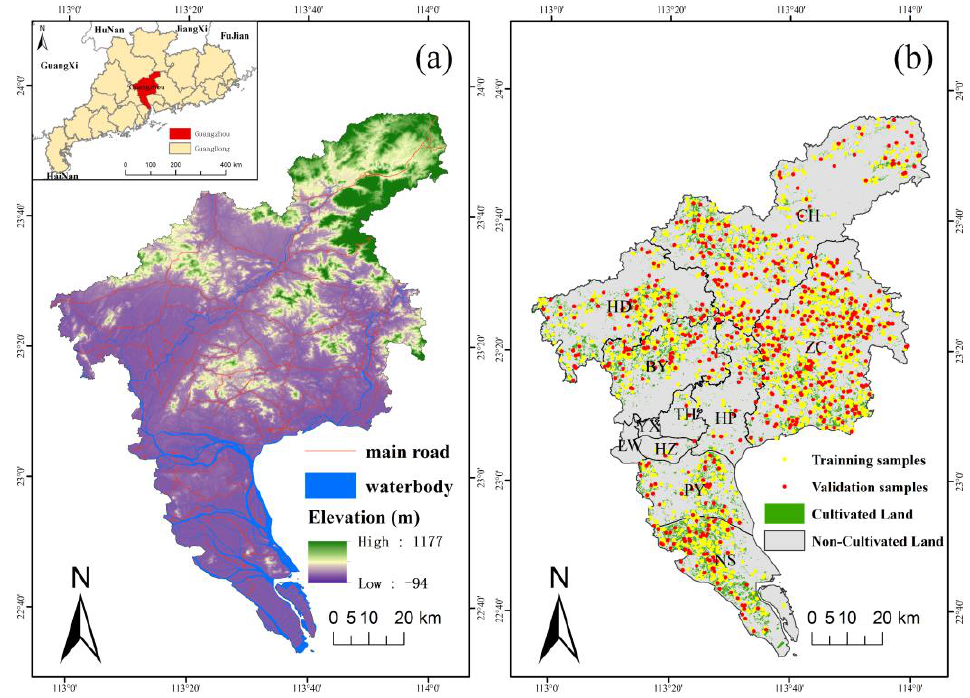
Figure 1. Study area and sample distribution: ( a ) location of Guangzhou City and altitude above sea level; ( b ) the spatial distribution of 2000 CLQ samples (the training sample plots are in yellow, and the validation sample plots are in red) and the current administrative divisions of Guangzhou City.